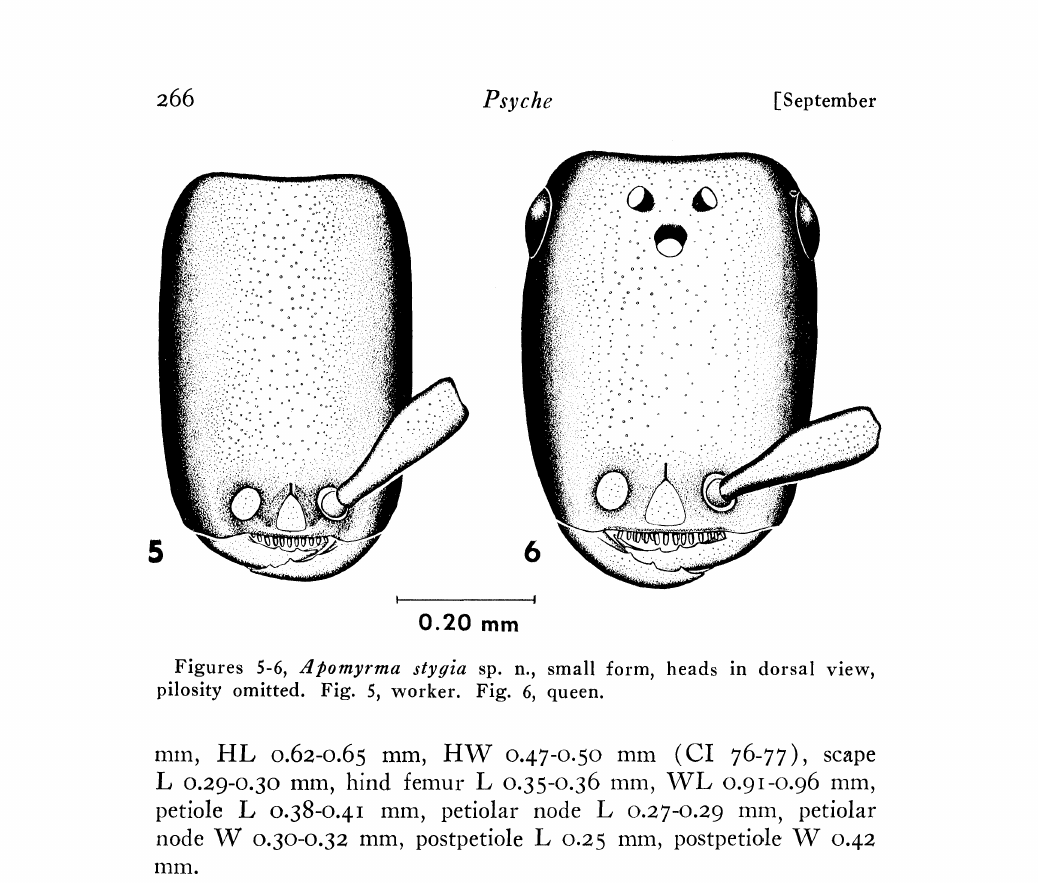
Figures 5-6, tpomyrma stygia sp. n., small form, heads in dorsal view, pilosity omitted. Fig. 5, worker. Fig. 6,